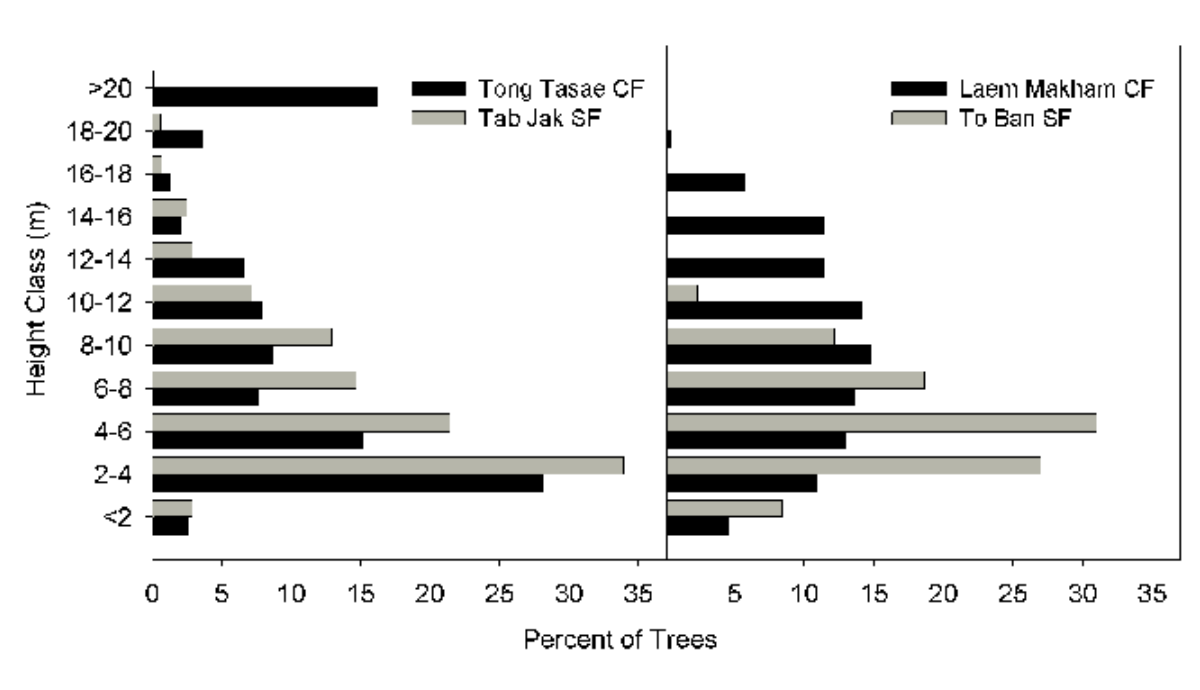
Fig. 4. Tree height-class distributions in community-and state-managed mangrove forests in Trang, southern